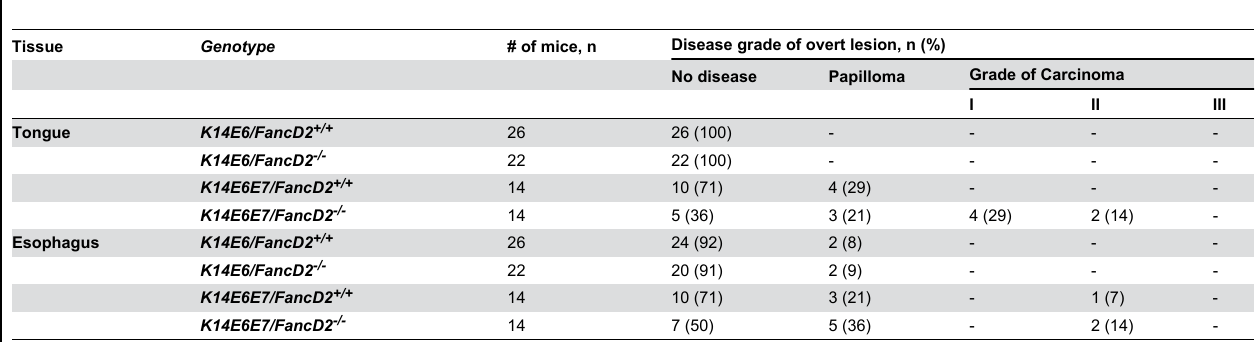
Table 2. Histopathological analysis of samples with overt lesions in the animal tongue and esophagus tissues.